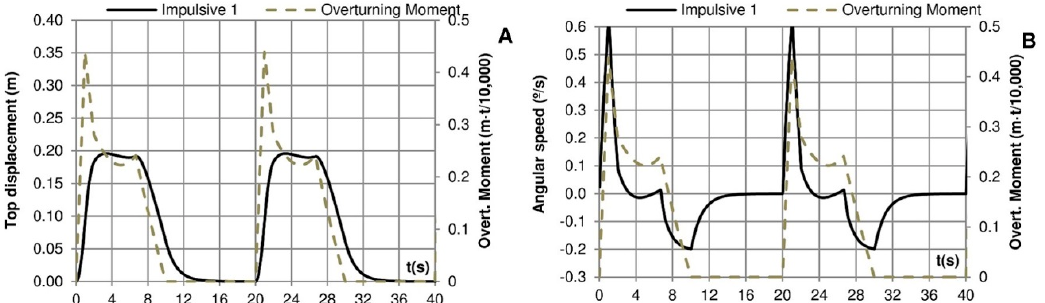
Figure 11. Impulsive 1. ( A ) Movement on the top of the crown wall; ( B ) angular velocity, related to overturning moment. E (MPa) = 10; 2 load cycles.